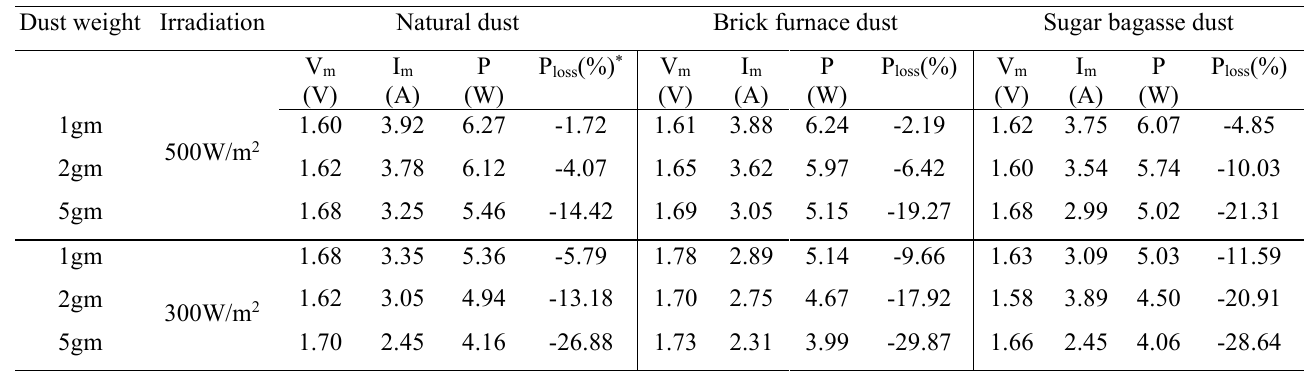
Table 9. Comparison of V m , I m and P with different weights of dust at 500/300W/m 2